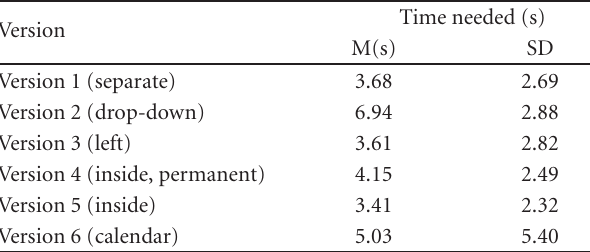
Table 2: Statistics for time needed to fill the